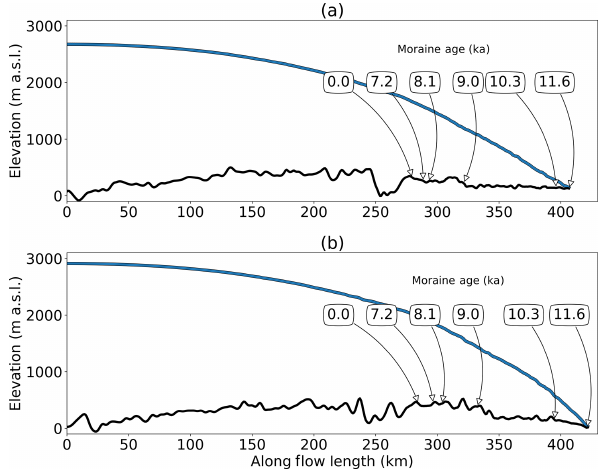
Figure 5. Initial ice sheet configurations for the northern (a) and southern (b) paleo-flow lines. Solid black and blue lines represent the bedrock elevation and ice surface, respectively. Moraine po- sitions are indicated by arrows with associated ages expressed in thousands of years before